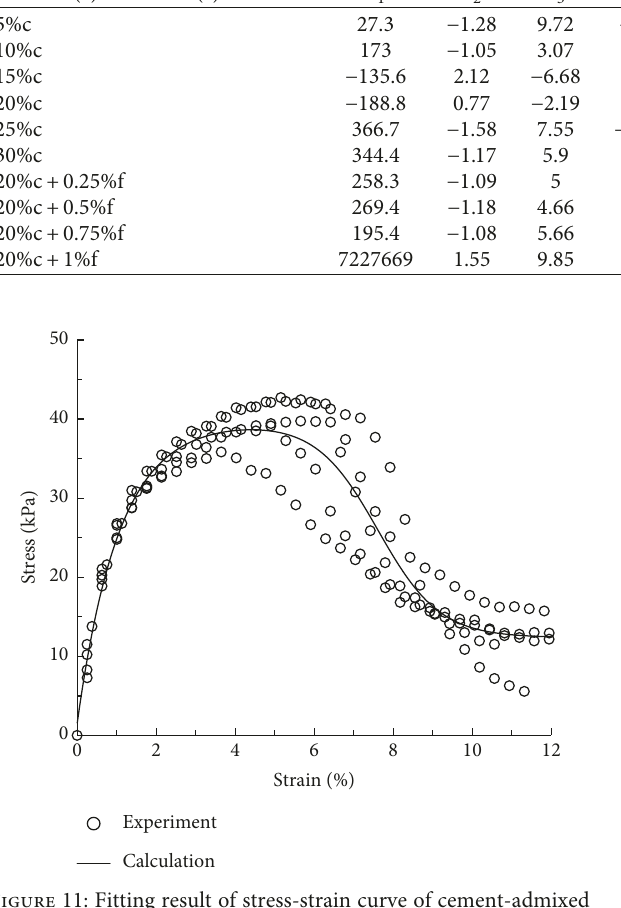
Figure 11: Fitting result of stress-strain curve of cement-admixed slurry with cement content of 5%.